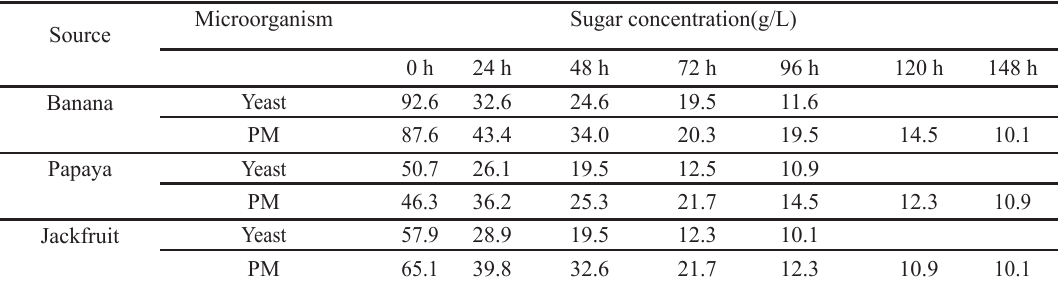
Table 2: Sugar concentrations at 24-h time intervals.